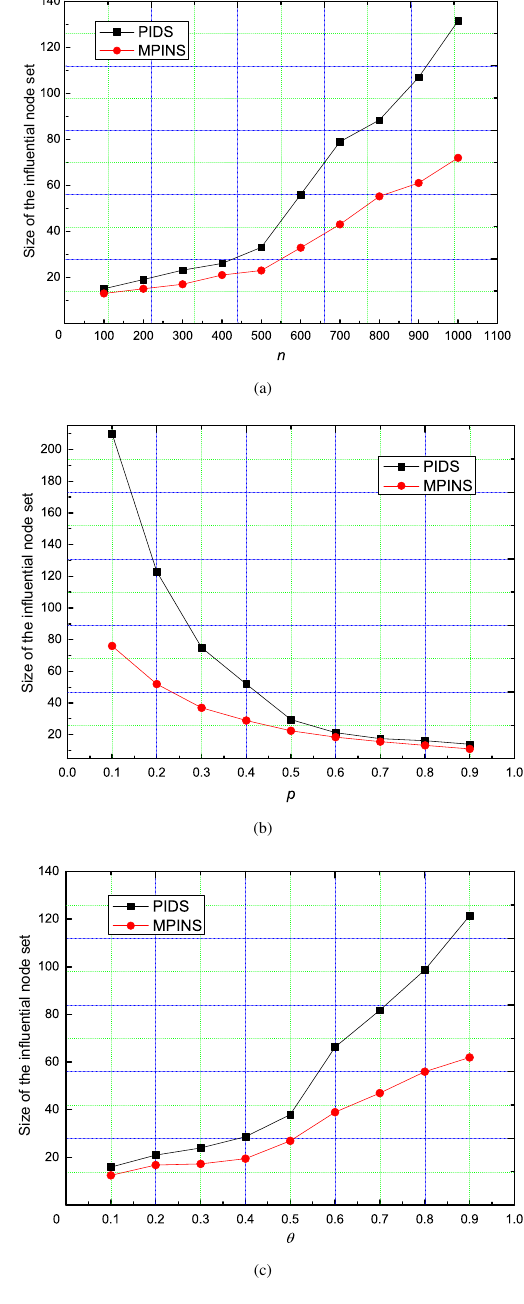
Fig. 5 Size of solutions on large scale networks: The default settings are n = 15, p = 0.5, and (cid:18)(cid:18)(cid:18) =